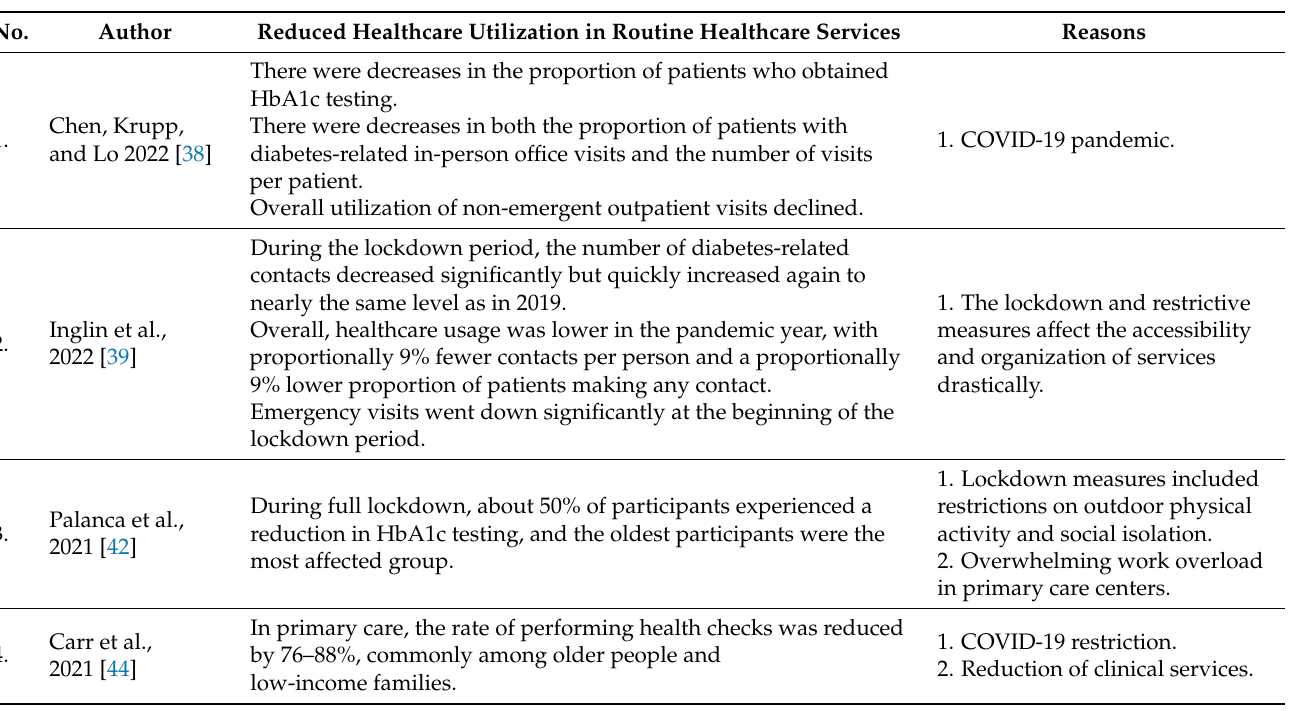
Table 4. Summary of reasons for reduced healthcare utilization in routine healthcare